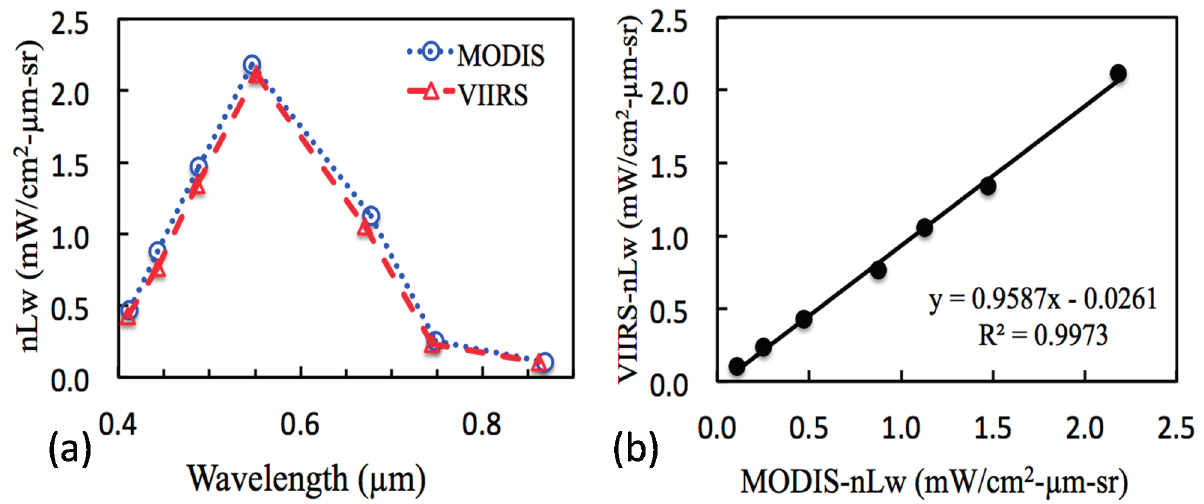
Figure 3. ( a ) Multi-channel normalized water-leaving radiances (nLw) of MODIS and VIIRS over Region 2 retrieved by APS, and ( b ) scatter plot of VIIRS versus MODIS nLw with the best-fit least-squares regression